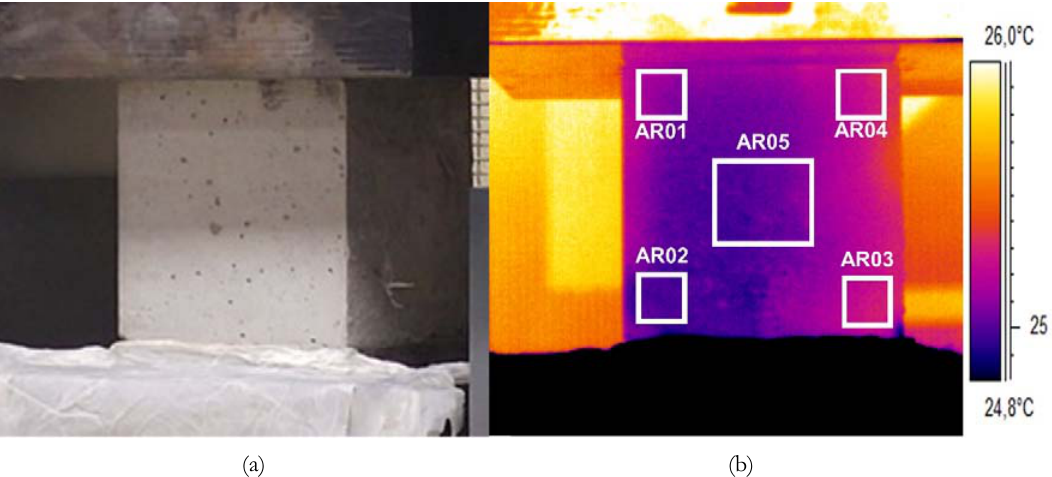
Figure 2: a) adopted specimen; b) thermal image of one face at the beginning of the test with the analysed areas (square). The maximum value of temperature within the five detection areas (AR01 to AR05) was recorded during the execution